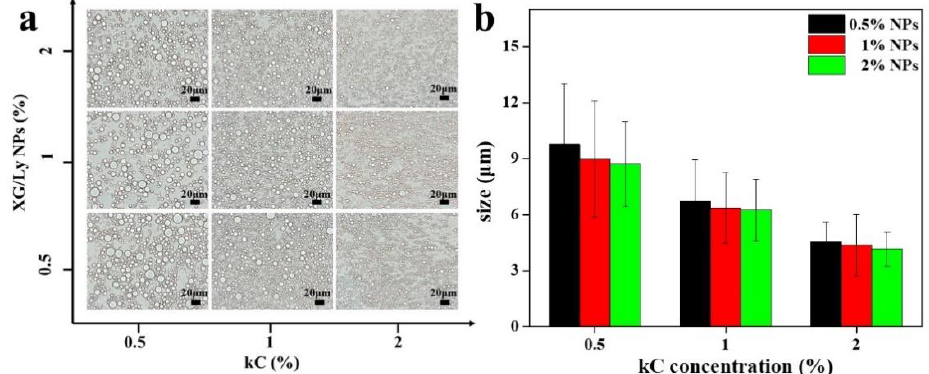
Figure 1. Optical microscope ( a ) and size distribution ( b ) of Pickering emulsion gel stabilized by XG/Ly NPs with kC.